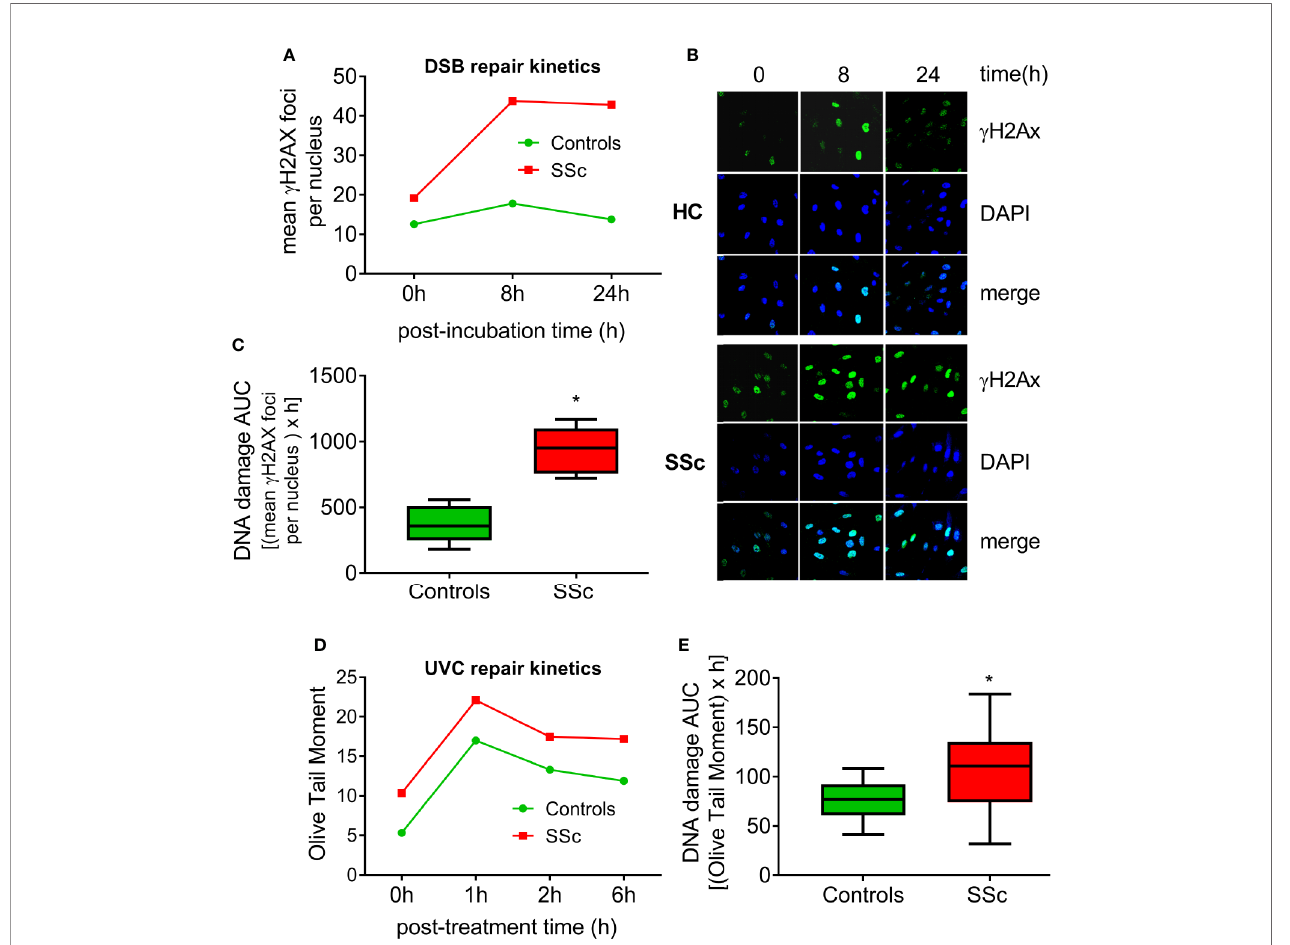
FIGURE 2 | Deregulated DNA repair mechanisms in SSc. (A) Line-graphs showing the kinetics of g H2AX formation and removal 0 – 24 h after treatment of freshly isolated PBMCs from HC ( n =9) and SSc patients ( n =9) with melphalan. (B) Confocal microscopy images showing g H2AX staining at different time points after the ex vivo treatment of PBMCs from a representative HC and an SSc patient with melphalan. Upper images, immuno fl uorescence antigen staining; middle, cell nuclei labeled with DAPI; bottom, merged. (C) Tukey boxplots representing DNA DSB accumulation ( g H2Ax immuno fl uorescence) 24 h after treatment with melphalan. (D) Line graphs showing levels of single- and double-strand DNA breaks (Olive tail moment) as assessed by alkaline comet assay in PBMCs of HC ( n =24) and SSc patients ( n =22) at baseline and 1, 2, and 6 h after ex vivo UVC irradiation of freshly isolated PBMCs with 5J/m 2 . (E) Tukey boxplots representing DNA SSB and DSB accumulation (alkaline comet assay) 6 h after treatment of PBMCs with 5J/m 2 UVC. *P<0.05 compared to